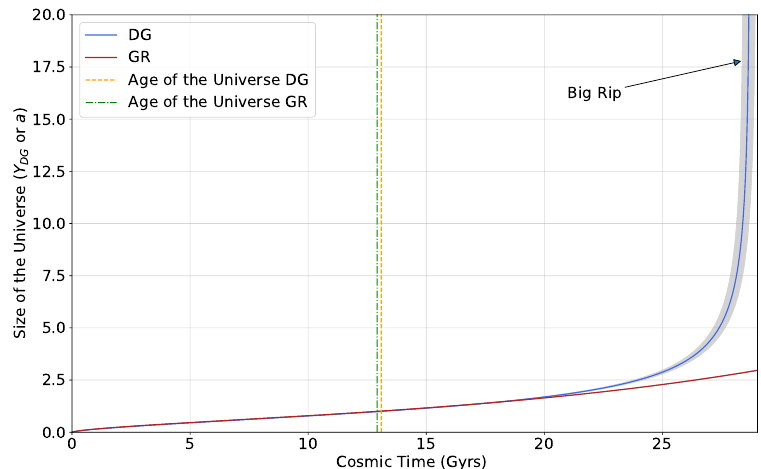
Figure 9. The size of the Universe vs. age of the Universe. In the Delta Gravity model, the size of the Universe Y DG depends on cosmic time t and on C . The blue line indicates the effective scale factor in Delta Gravity. The gray zone shows the error associated with Y DG . For GR, the scale factor a depends on cosmic time t and on Ω m 0 . The red line indicates the scale factor evolution in GR. The gray zone shows the error associated with a (these are tiny).